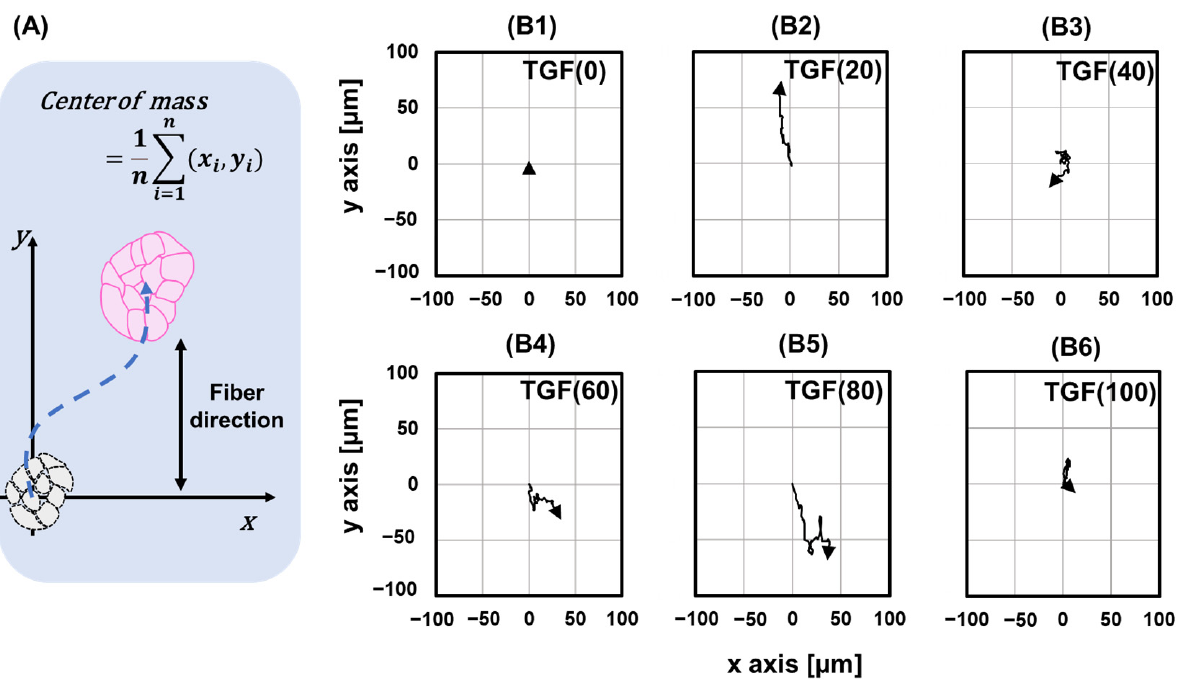
Figure 3. Changes in the location of the colony center. ( A ) Definition of center of mass. ( B1 – B6 ) Movement of center of mass under different TGF (N).